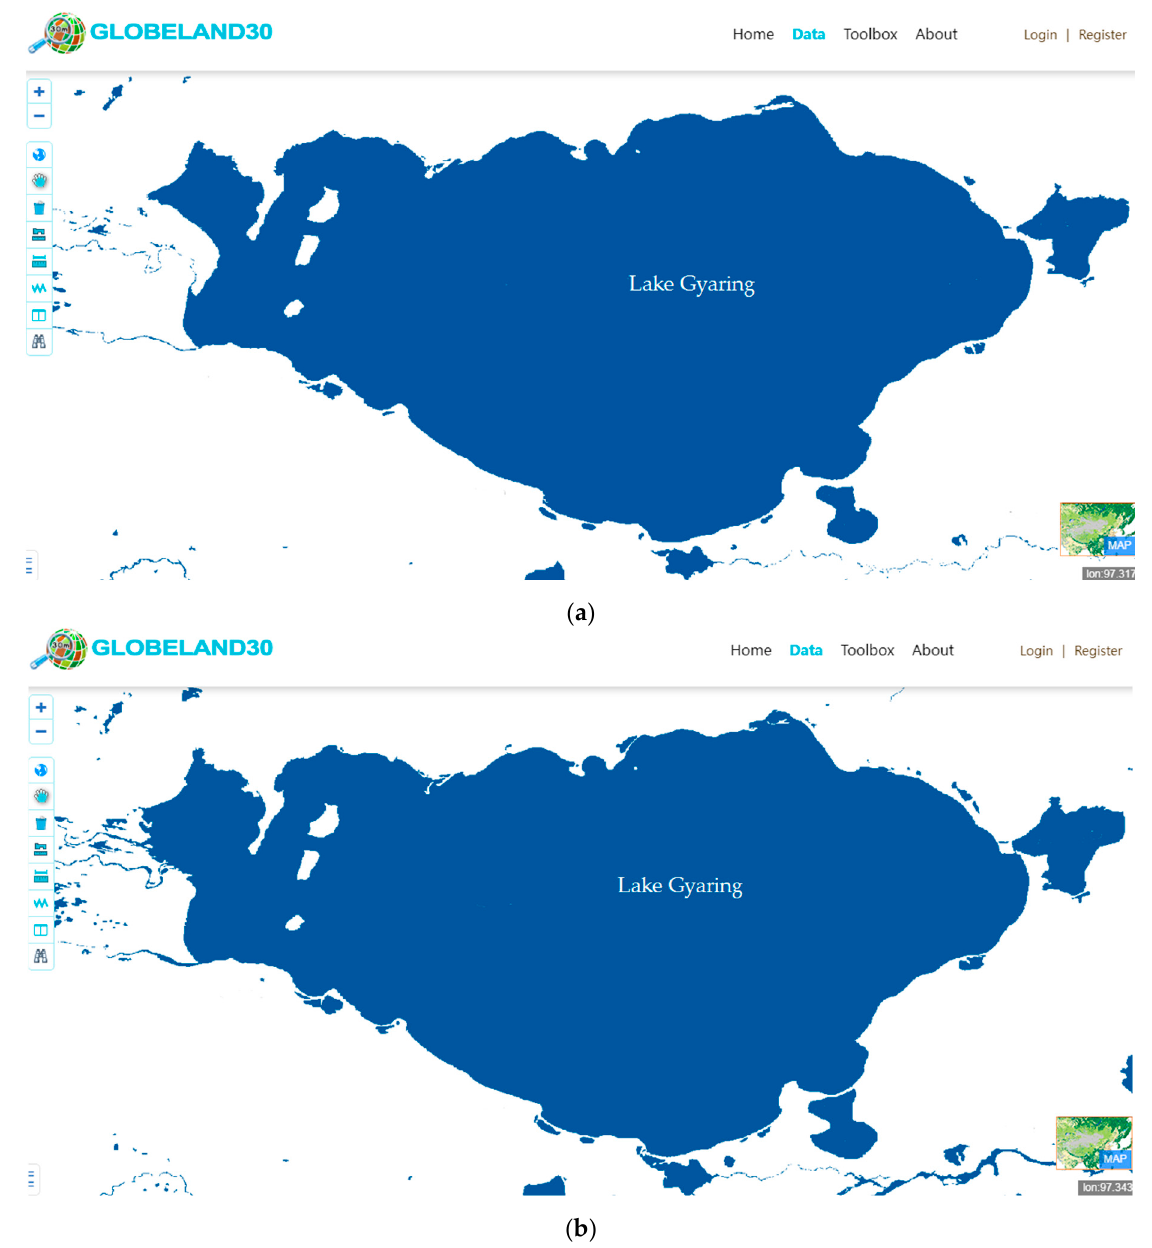
Figure 5. Water bodies of Lake Gyaring in 2000 and 2020 in GLOBELAND30: ( a ) water bodies of Lake Gyaring in 2000 in GLOBELAND30; ( b ) water bodies of Lake Gyaring in 2000 in GLOBELAND30.